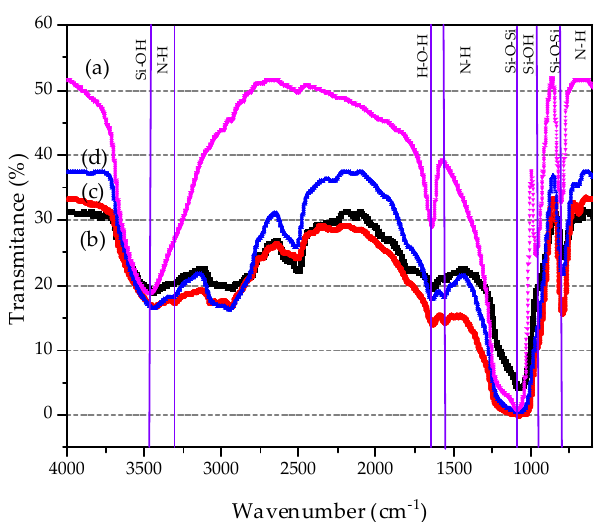
Figure 4. Fourier ‐ Transformed Infrared spectra of ( a ) bare DMS ‐ 1 material, ( b ) 0.2NH 2 /DMS ‐ 1, ( c ) 0.3NH 2 /DMS ‐ 1, and ( d ) 0.4NH 2 /DMS ‐ 1